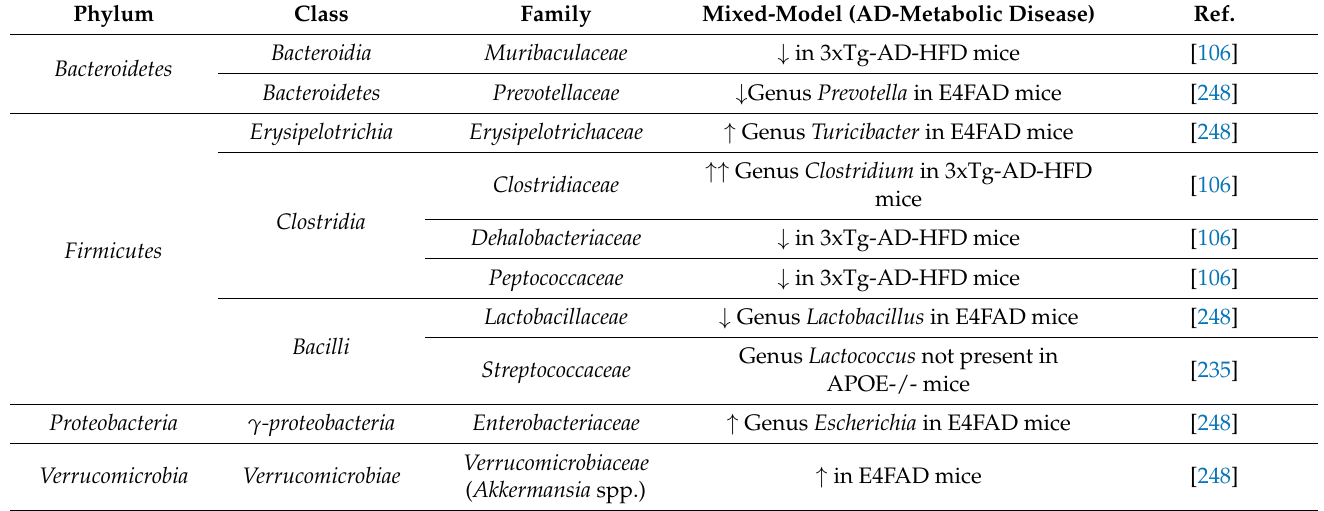
Table 3. Alterations of gut composition in AD and metabolic disease animal